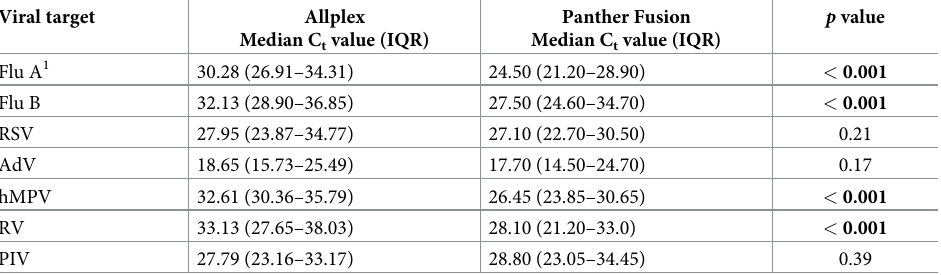
Table 6. Comparison of amplification efficiency for Allplex and Panther Fusion